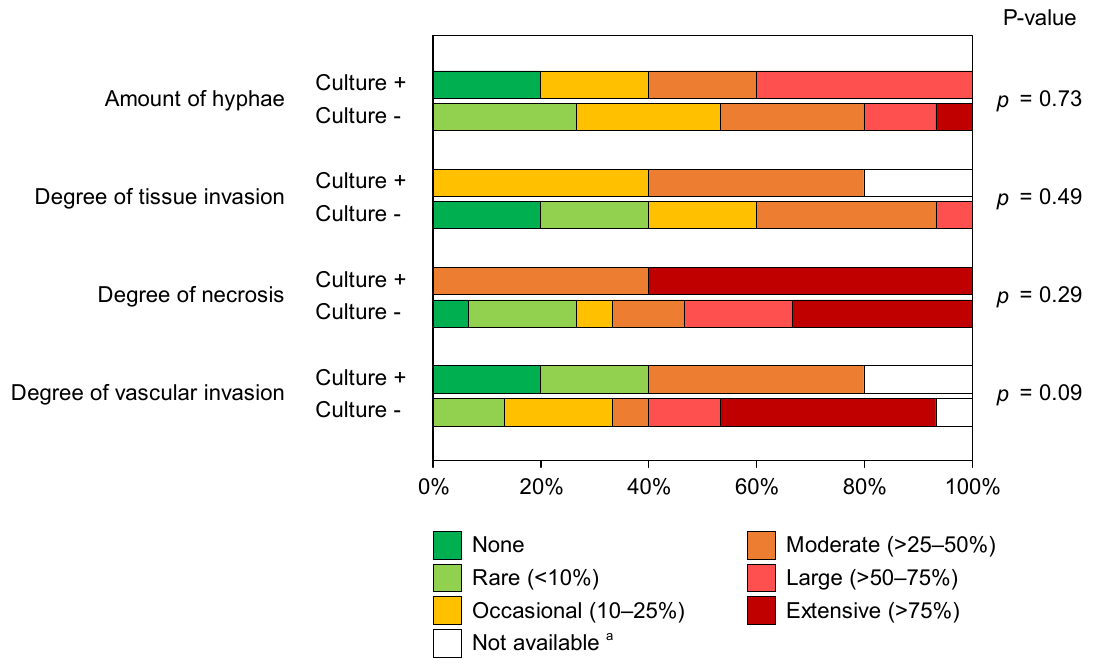
Abbreviations and footnotes for Table 2. Abbreviation: GVHD = graft-versus-host disease. Foot-